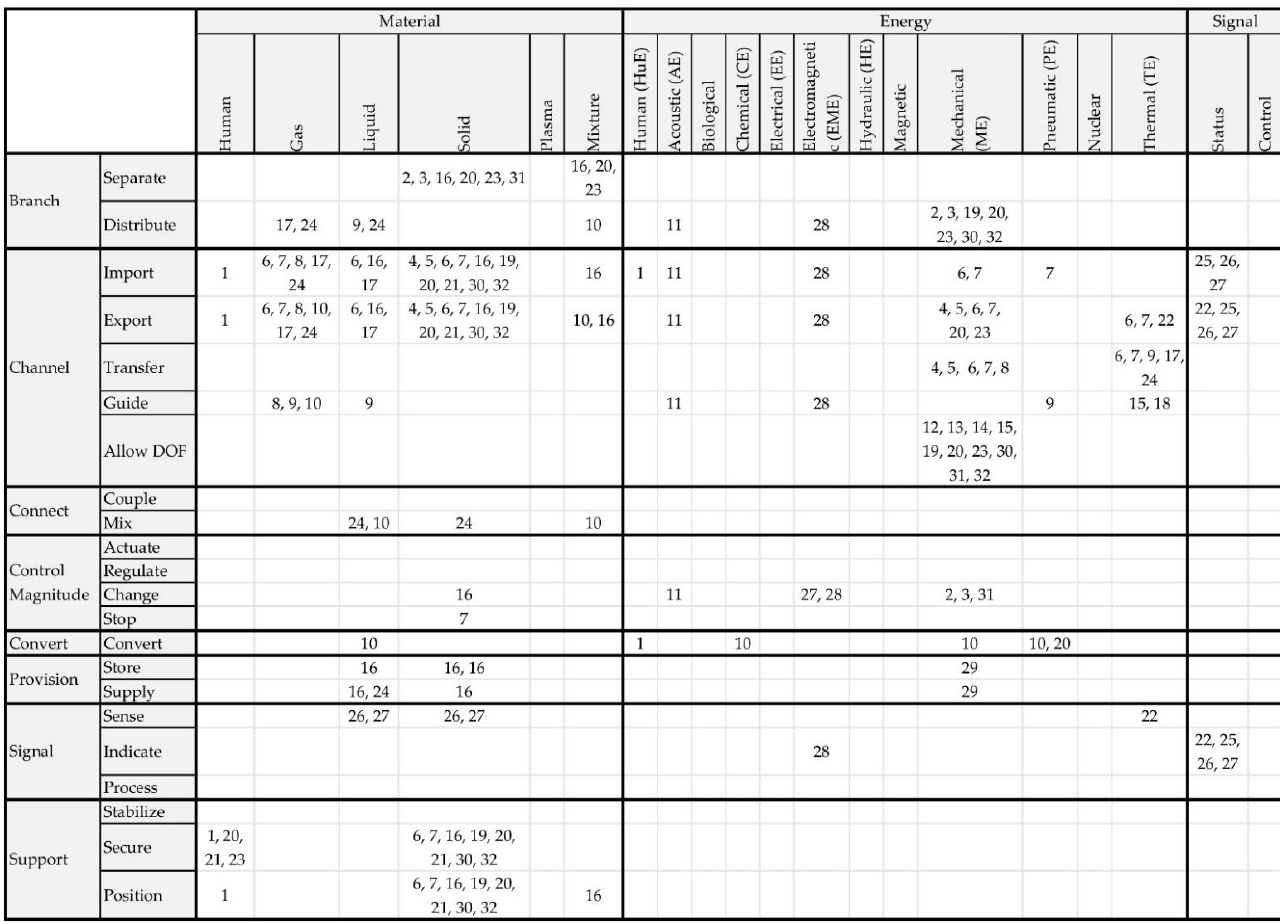
Figure 5. Function-Flow-Design Principle Matrix.